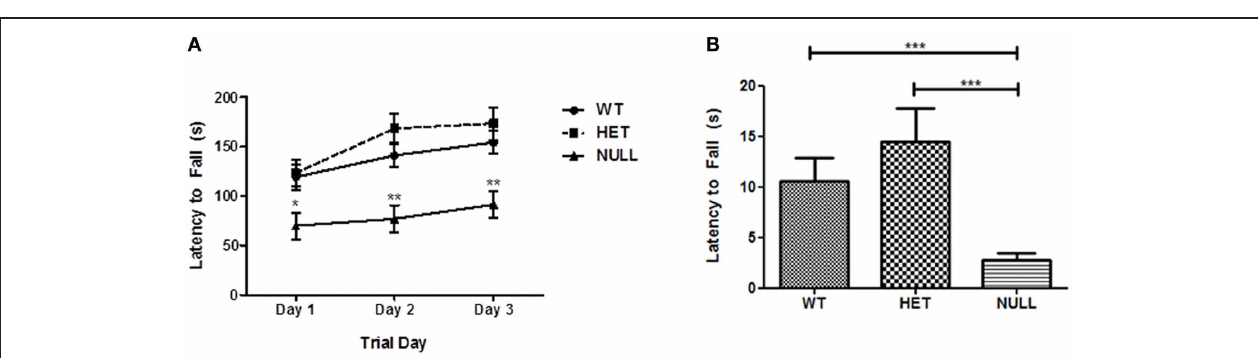
FIGURE 1 | Weight analysis. G α q knockout mice are smaller than their wildtype littermates as shown in the photomicrograph in (A) . (B) shows the average weight of each genotype at the time of initial testing ( ∼ 2–3 months of age). G α q knockout mice weigh significantly less than wildtype